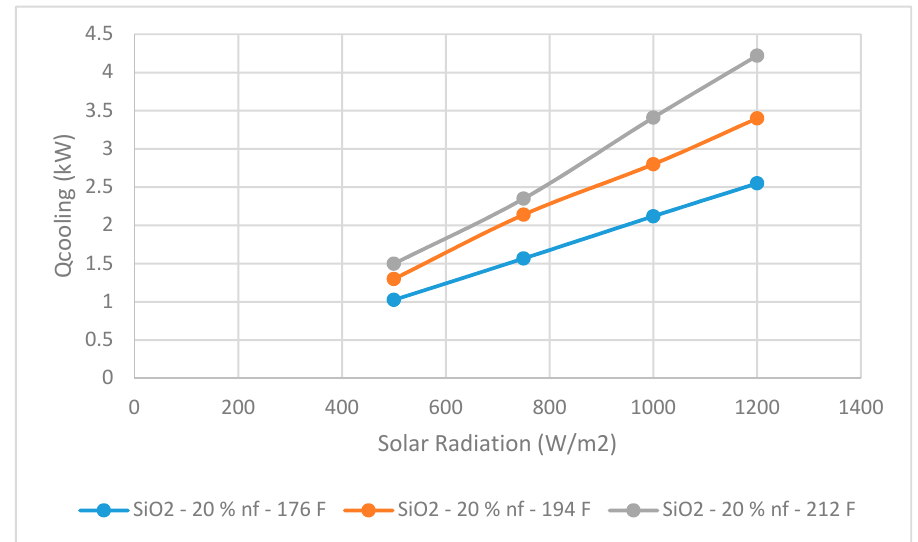
ff ect produced with SiO